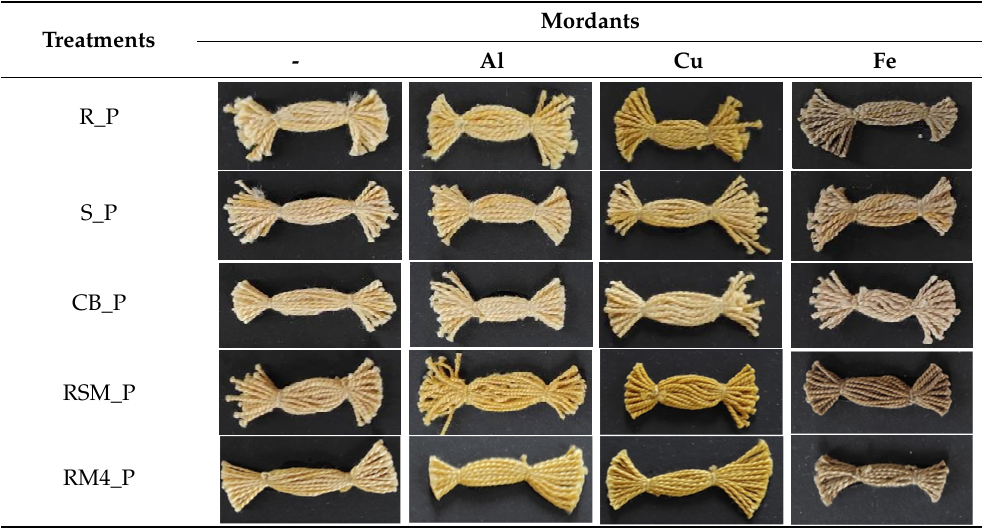
Table 6. Cotton yarns dyed with pomegranate peel.